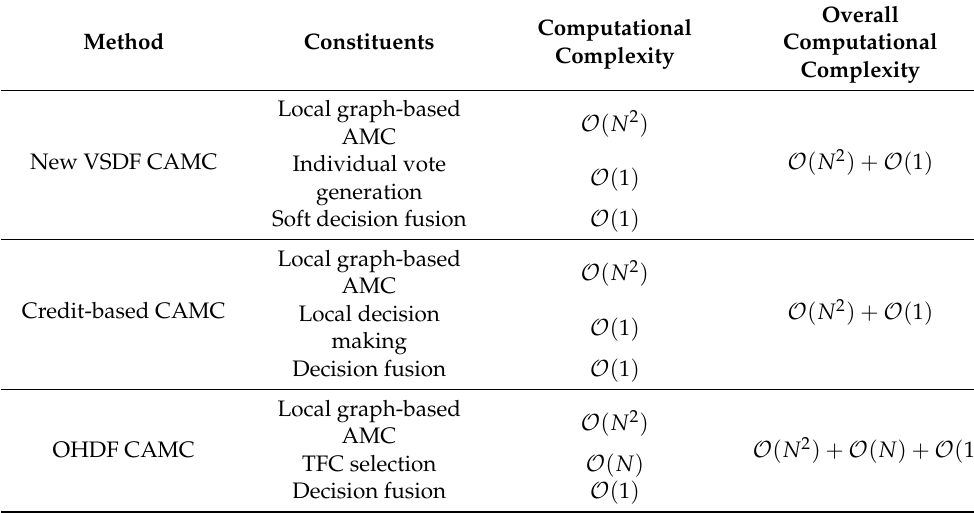
Table 1. Computational complexities of our proposed new VSDF CAMC approach, the existing credit-based CAMC method in [23] and the existing OHDF CAMC method in